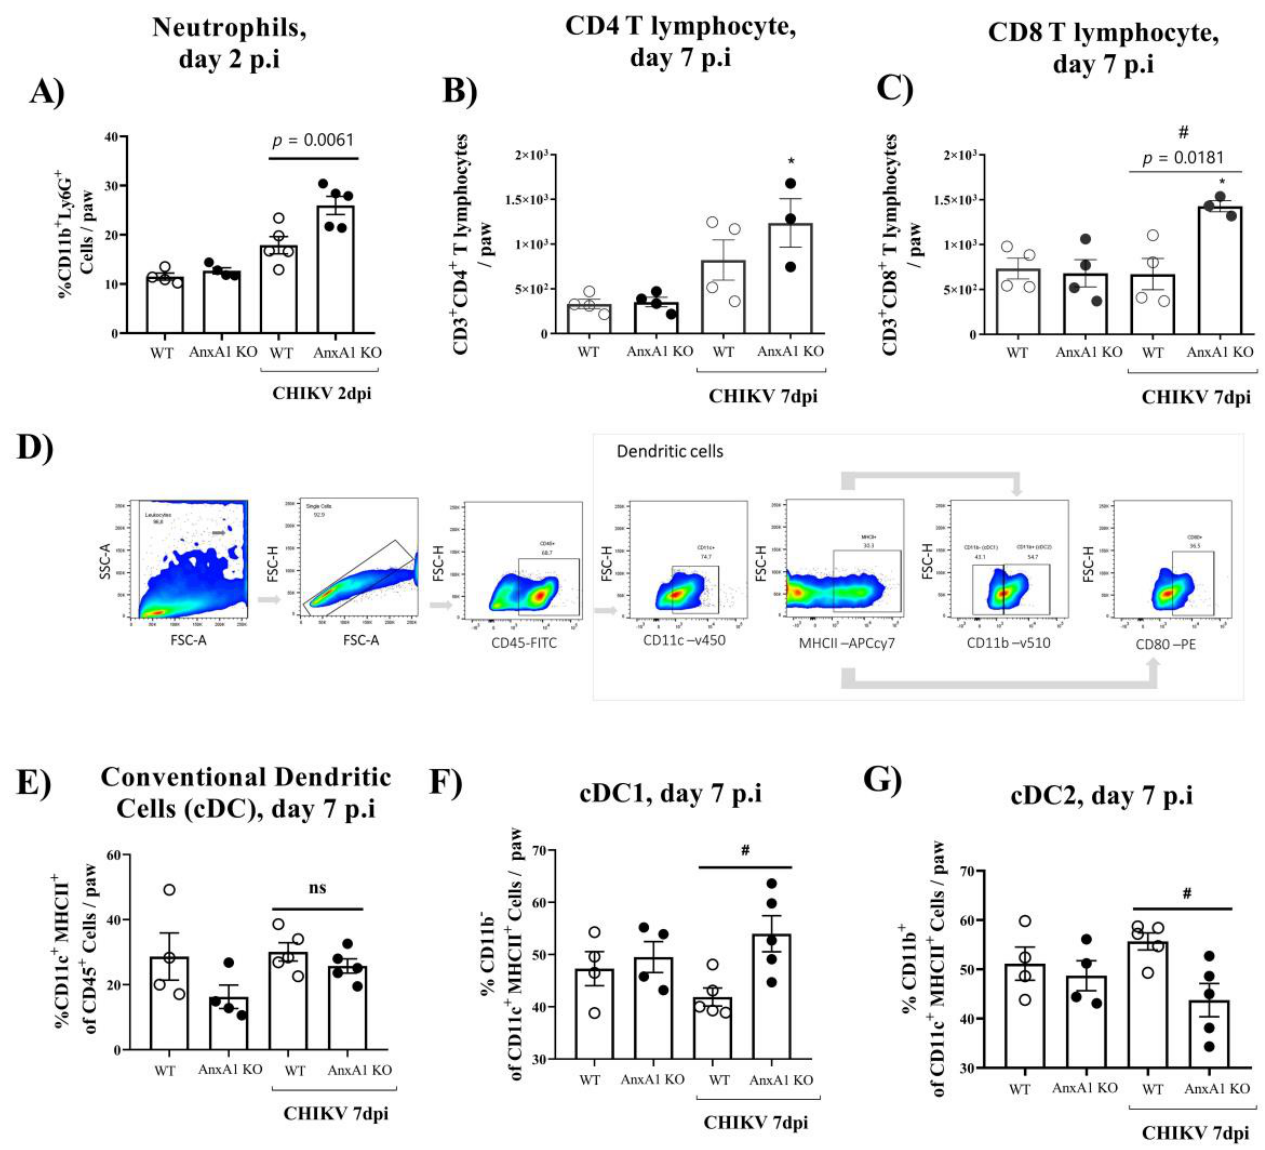
Figure 4. Immune cell accumulation in the paw of AnxA1 KO or WT mice infected with CHIKV. ( A ) Percentage of neutrophils, ( B ) CD4 + T cells, ( C ) CD8 + T cells, ( D ) gate strategy, ( E ) Conventional dendritic cells (cDC), ( F ) cDC1, ( G ) cDC2, per footpad at 2 or 7 dpi. Statistical significance was calculated using one-way ANOVA with Tukey comparisons test. Data are presented as mean ± SEM ( n = 4–5 per group); * p < 0.05. when compared with the uninfected control (mock) or # p < 0.05 when compared with AnxA1 KO and WT infected